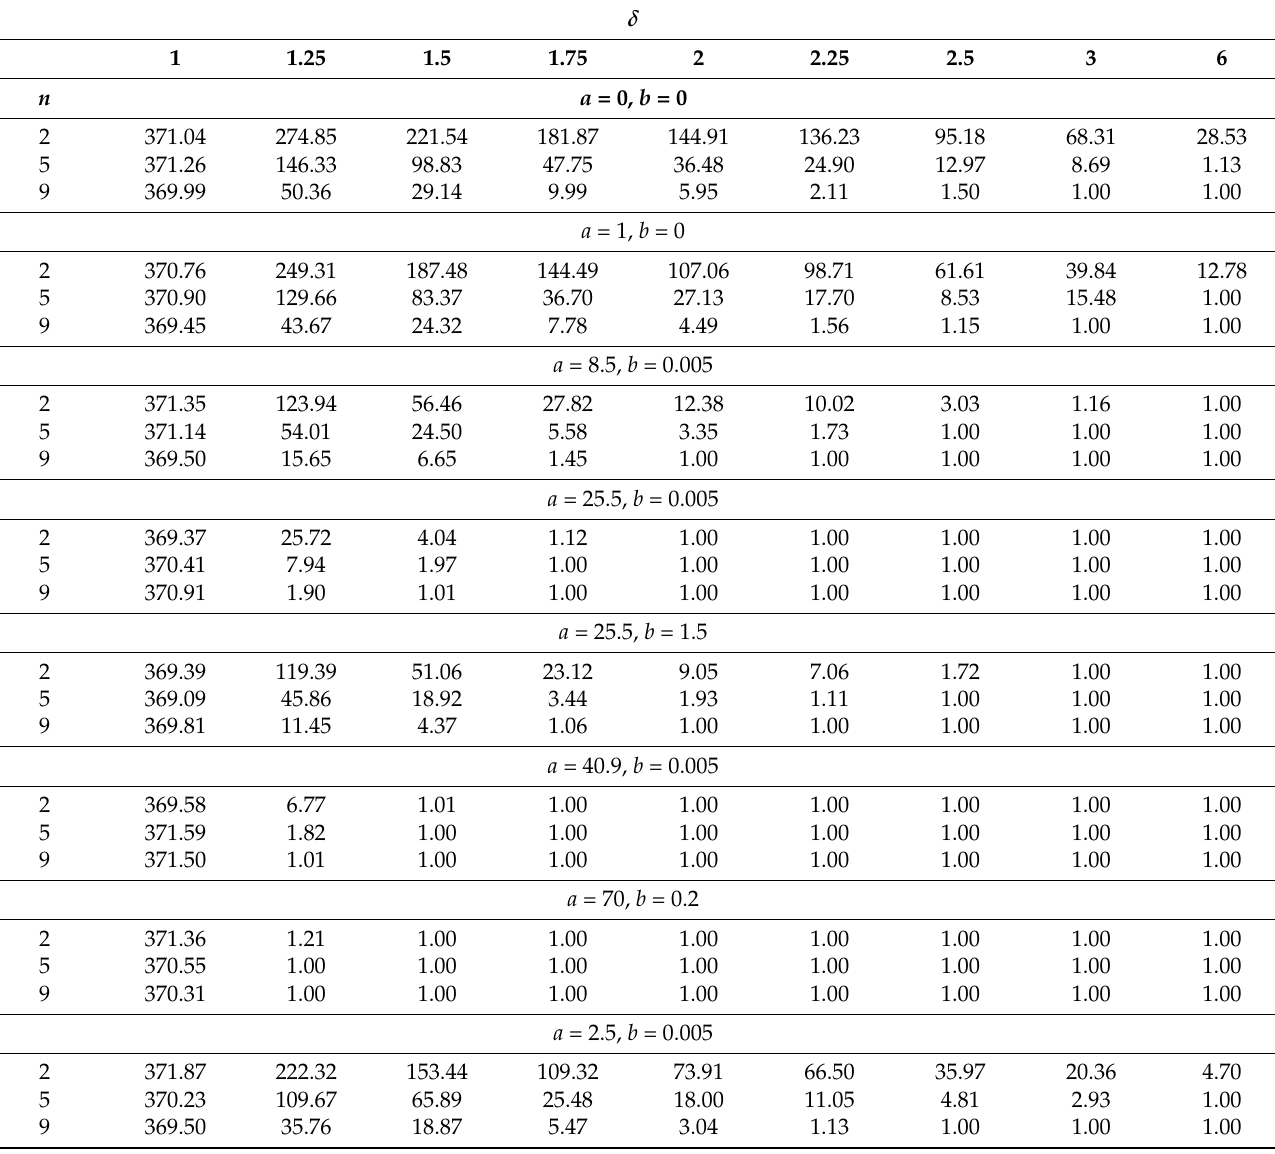
Table 4. Run length profile of the Bayesian-II Shewhart-type control chart with different sample sizes and hyperparameter values at α = 0.0027 with ARL ≈